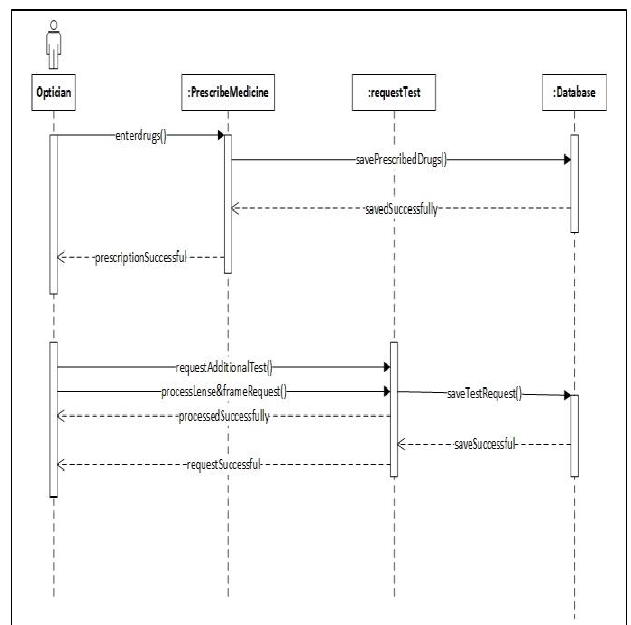
Figure 13. Optician Sequence Diagram Data-Flow Diagram